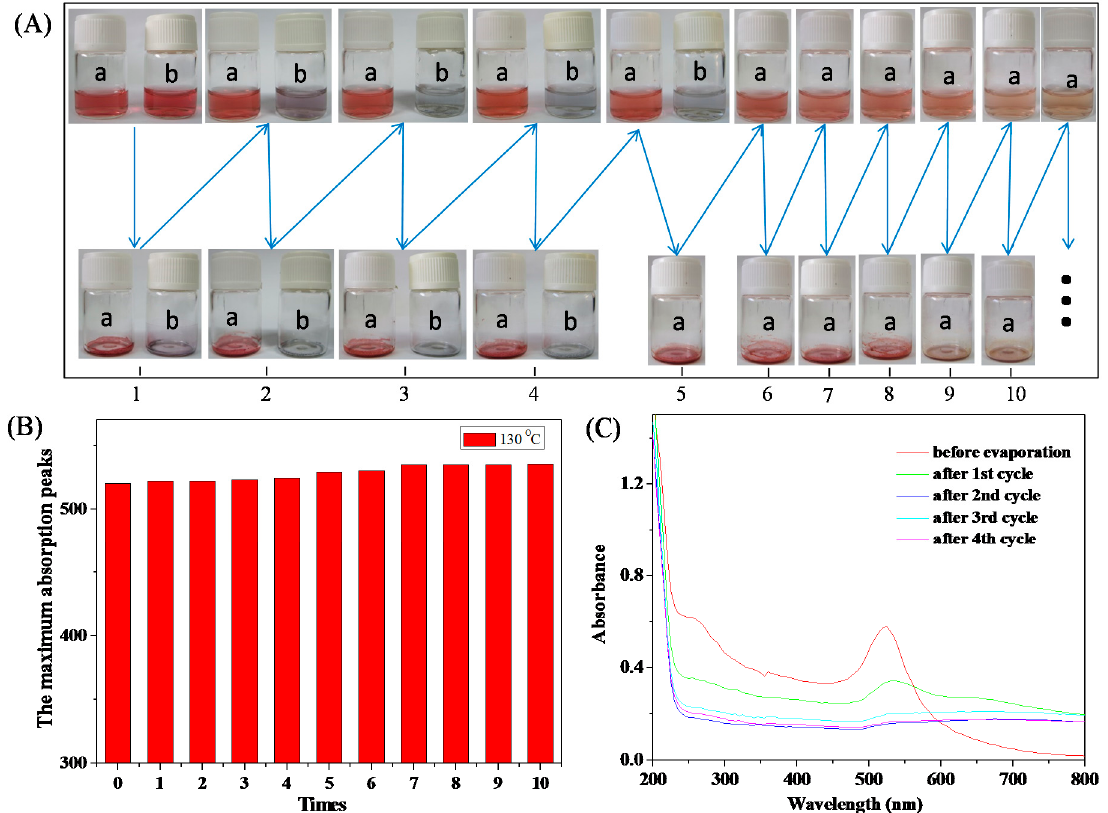
Figure 3. ( A ) Photographs of (a) the HPEI-IBAm functionalized AuNPs and (b) citrate-capped AuNPs after every evaporation at 130 °C and re-dispersion in Milli-Q water; ( B ) the maximum absorption peaks of the HPEI-IBAm functionalized AuNPs after each cycle’s re-dispersion; ( C ) the UV-Vis spectra of the citrate-capped AuNPs after each cycle’s re-dispersion.